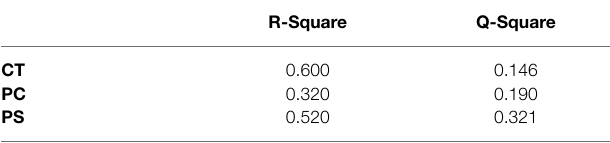
TABLE 4 | R-Square values and Q-Square values for the variables.